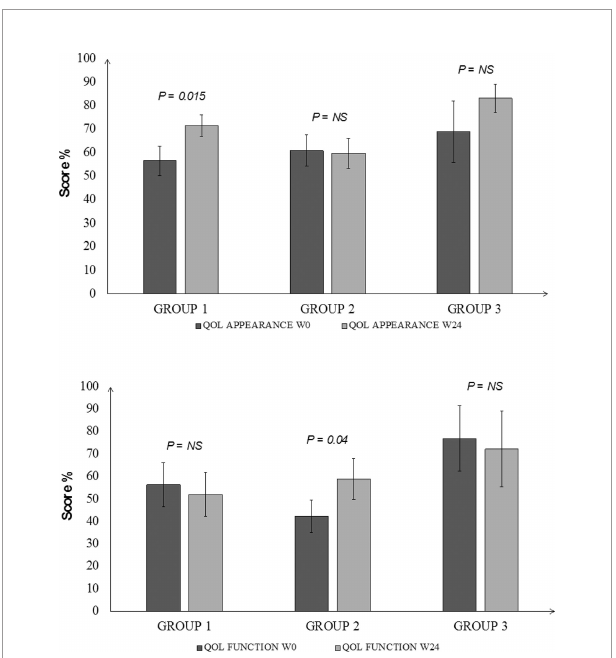
FIGURE 3 | Changes in the baseline score of the Quality of Life assessment of patients with GO at 24 weeks after treatment with different doses of RTX. Panel (A) (upper): appearance score, Panel (B) (lower): function score. Group 1 = 100 mg; Group 2 = 500 mg; group 3 = 1000 mg x 2; baseline values are in dark grey and values at 24 weeks in light grey. Wilcoxon matched pair test.